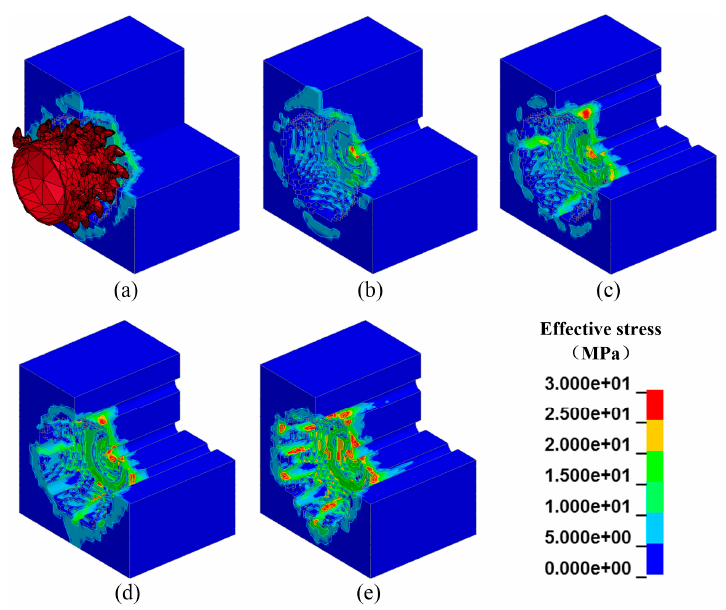
Figure 6. Von Mises effective stress contours of rocks containing different numbers of holes at the advance time of 25 s: ( a ) no holes; ( b ) one hole; ( c ) five holes; ( d ) nine holes; and ( e ) 13 holes.